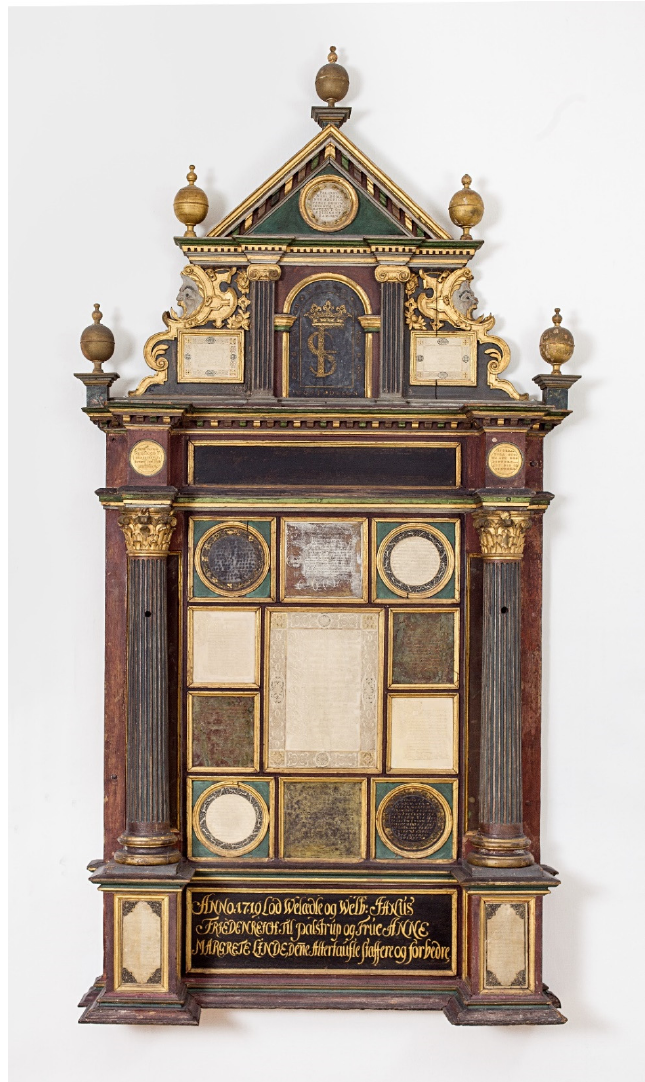
Figure 4. Peder Trellund’s devotional image (Inv.nr. D1210) from 1586 in the Danish National Museum. Photo: Arnold Mikkelsen, The Danish National Museum.